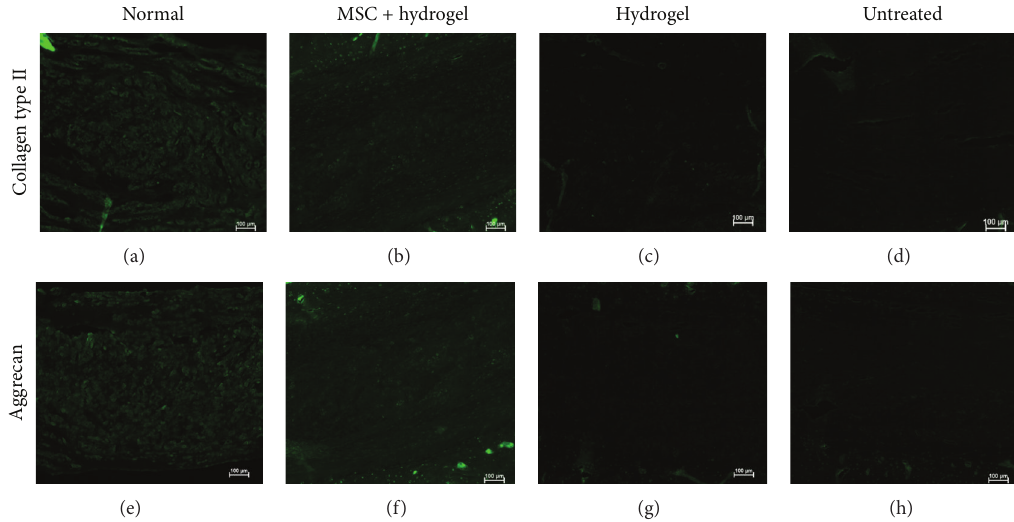
Figure 10: Immunohistochemical staining of different groups stained for collagen type II and aggrecan. Normal group (a, e), MSC and hydrogel group (b, f), hydrogel group (c, g), and untreated defect group (d,